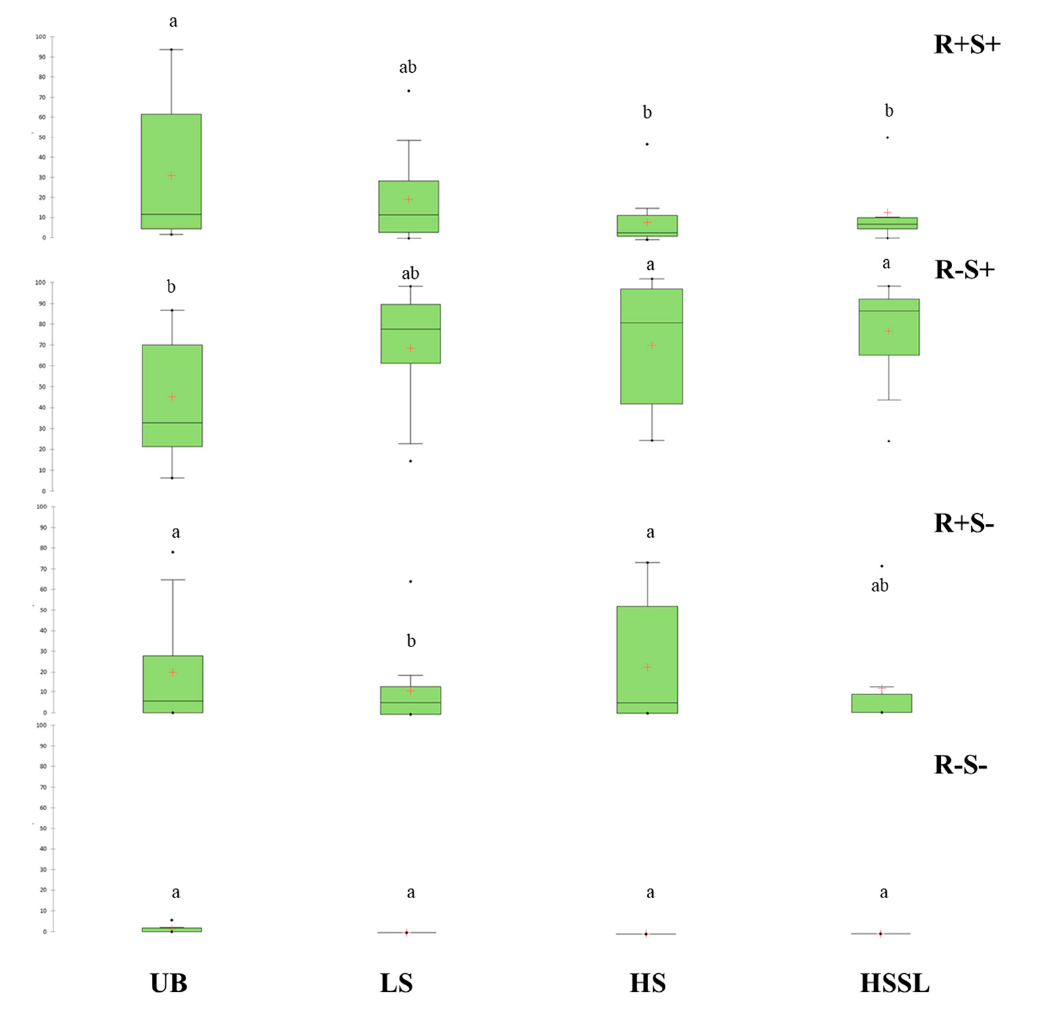
Figure 3. Box and whiskers ANOVA (limits of boxplots represent upper and lower quartiles, the central line is the median, asterisks are outliers, and whiskers indicate the highest and lowest observations) showing averaged coverages of visually estimated species (red cross) recorded according to post-fire trait adaptive strategies (TRAIT, %)): non-adaptive post-fire traits (R-S-), obligate seeder (R-S + ), obligate resprouters (R + S-), and facultative seeder (R + S + ). The plots sampled five years after the fire were set in unburned natural Aleppo pine stands (UB), low-burn severity (LS), high-burn severity unmanaged (HS), and high-burn severity after post-fire salvage logging (HSSL). Different lowercase letters in each column indicate significant differences between the means of groups (Tukey honest significant difference (HSD), p <